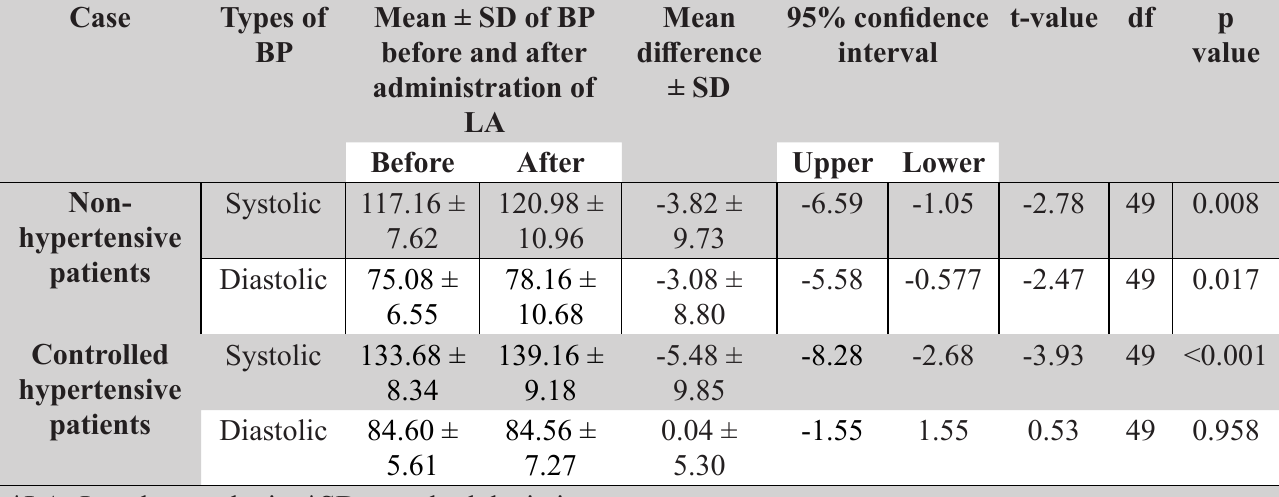
Table 1: Mean Blood pressure (BP) before and after administration of local anesthetic with adrenaline in controlled hypertensive and non-hypertensive